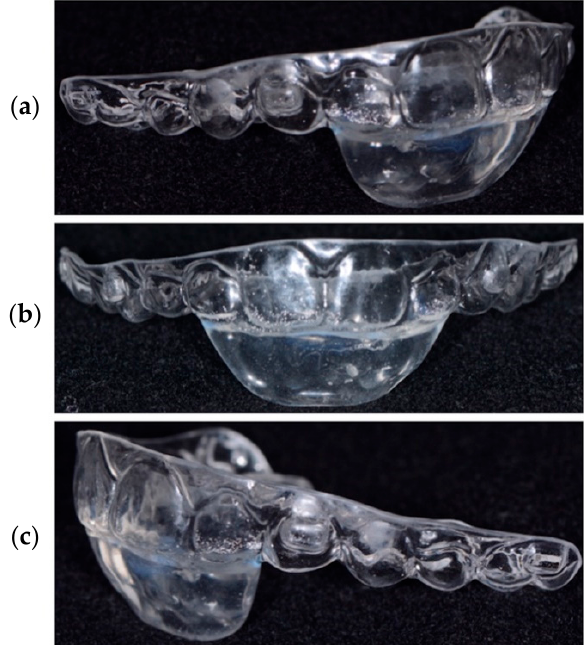
Figure 1. ( a – c ) F22 Young.